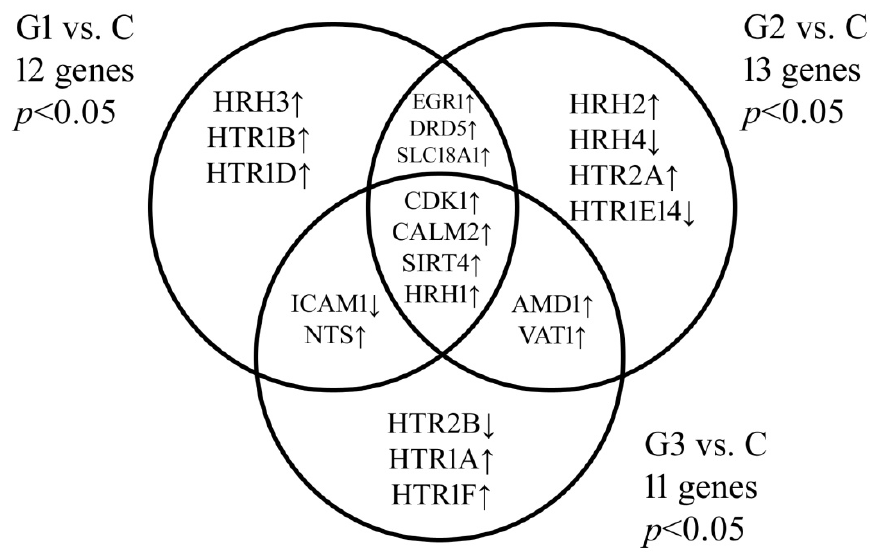
Figure 1. Venn diagram of microarray results showing genes differentiating endometrial cancer from the control group. C, control group; G, endometrial cancer grade; p < 0.05 vs. the C group. The results showed that the expression of CDK1 , CALM2, and SIRT4 was significantly increased in all grades of endometrial cancer compared to the control group. The HRH1 and HRH2 genes were characteristic of G1 and G2 EC, respectively. HRH1 was also common to the G2 and G3 samples. An increased level was also noted for HRH3 , while HRH4